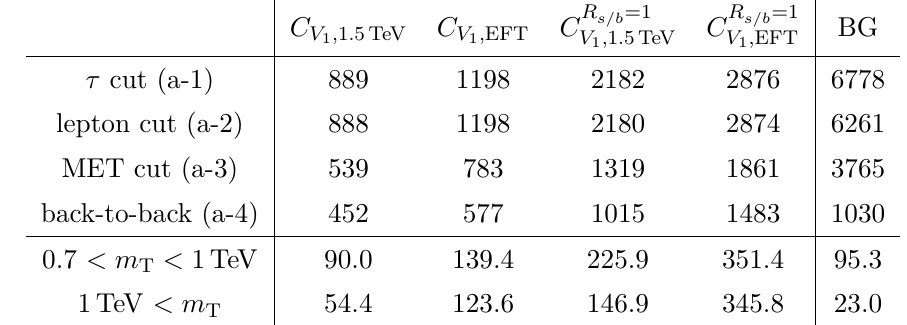
Table 11 . Cut flows of the signal event numbers in the cut a category for several setups of the C V R L dt scenario with C V = 1 and = 35 . 9 fb − 1 . See the caption of table 3 for the details. 1